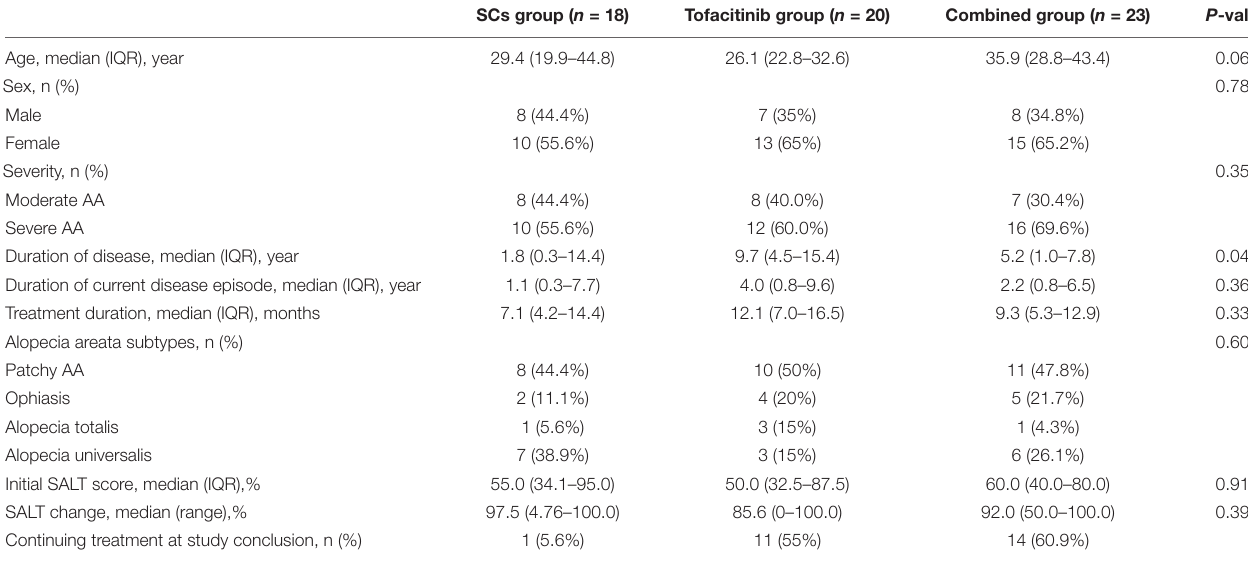
TABLE 1 | Demographic data and characteristics of patients with AA in each group.